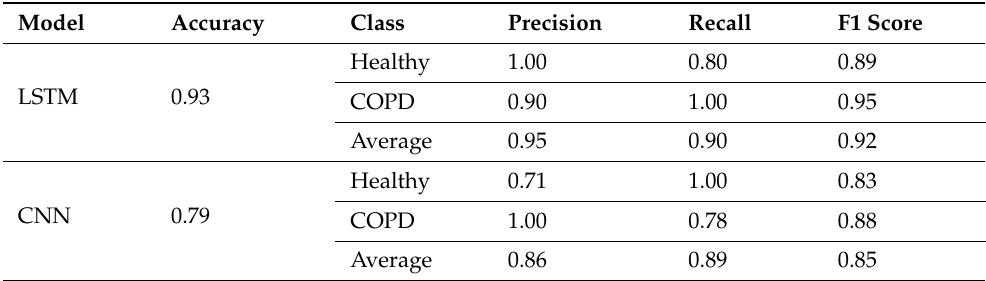
Table 5. COPD classification results using deep-learning models.